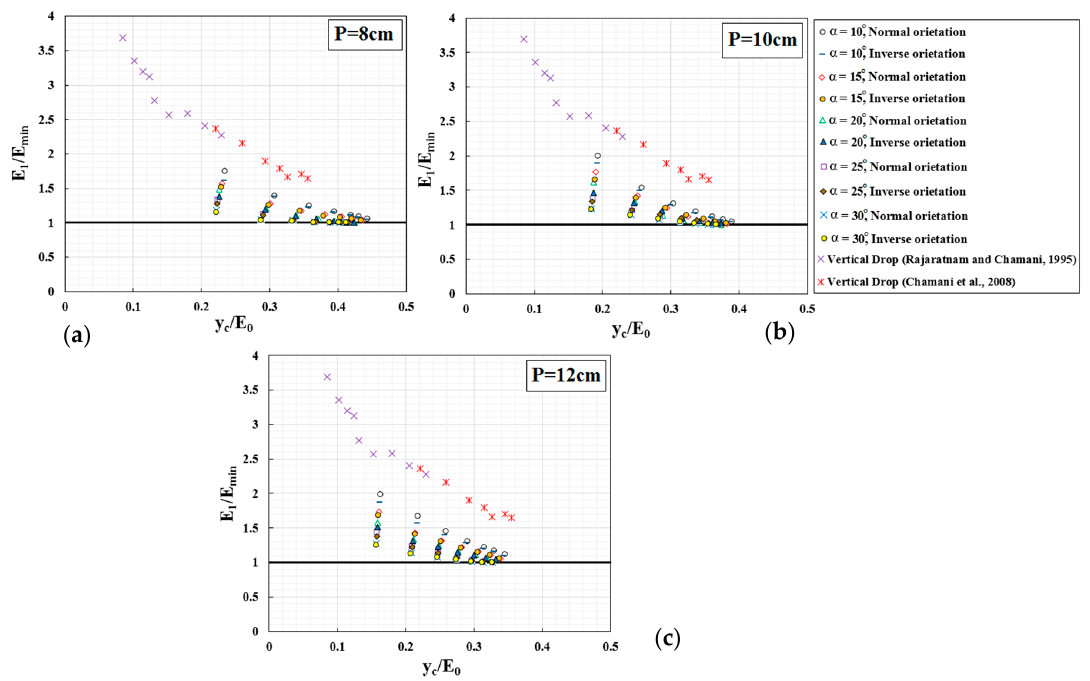
Figure 14. Comparison of the residual energy downstream of TTLW with a vertical drop, and minimum residual energy ( E 1 / E min versus y c / E 0 ), ( a ) P = 8 cm, ( b ) P = 10 cm, ( c ) P = 12 cm.